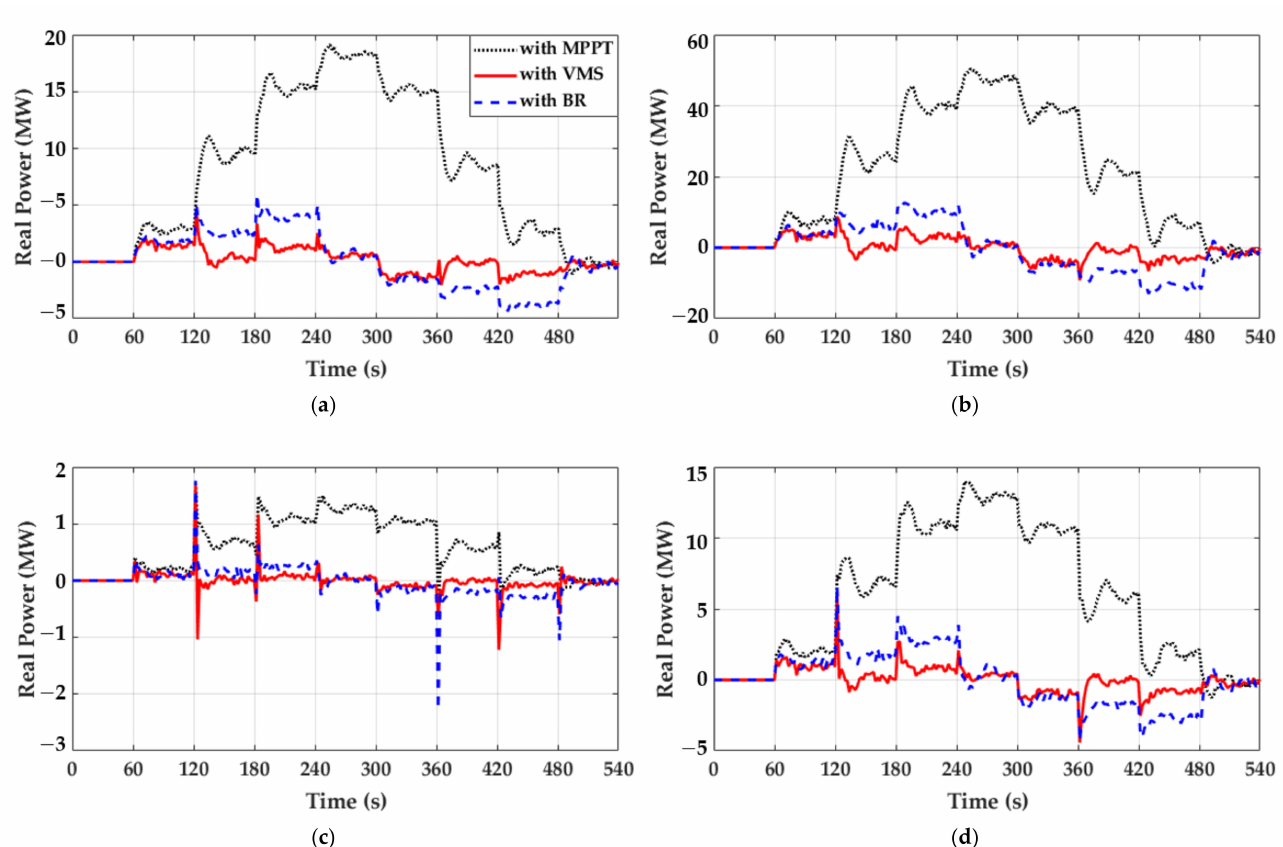
Figure 5. Total real power changes in ( a ) Area 1, ( b ) Area 2, ( c ) Area 3, and ( d ) the other areas, including Metro Area.